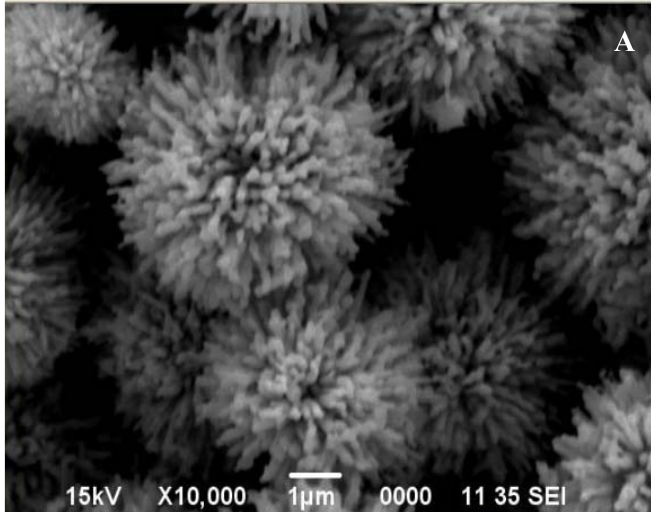
Figure 8. The TG ( A ) and DTA ( B ) curves of the Zn